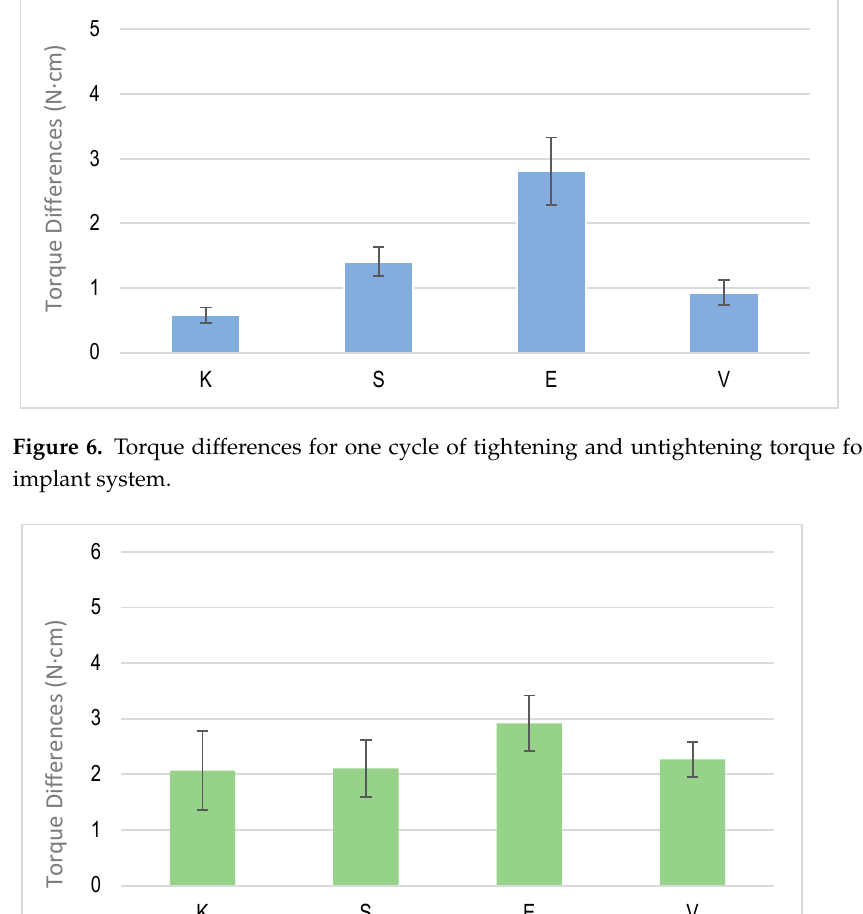
Figure 7. Torque differences for multiple cycles of tightening and untightening torque for each dental implant system.